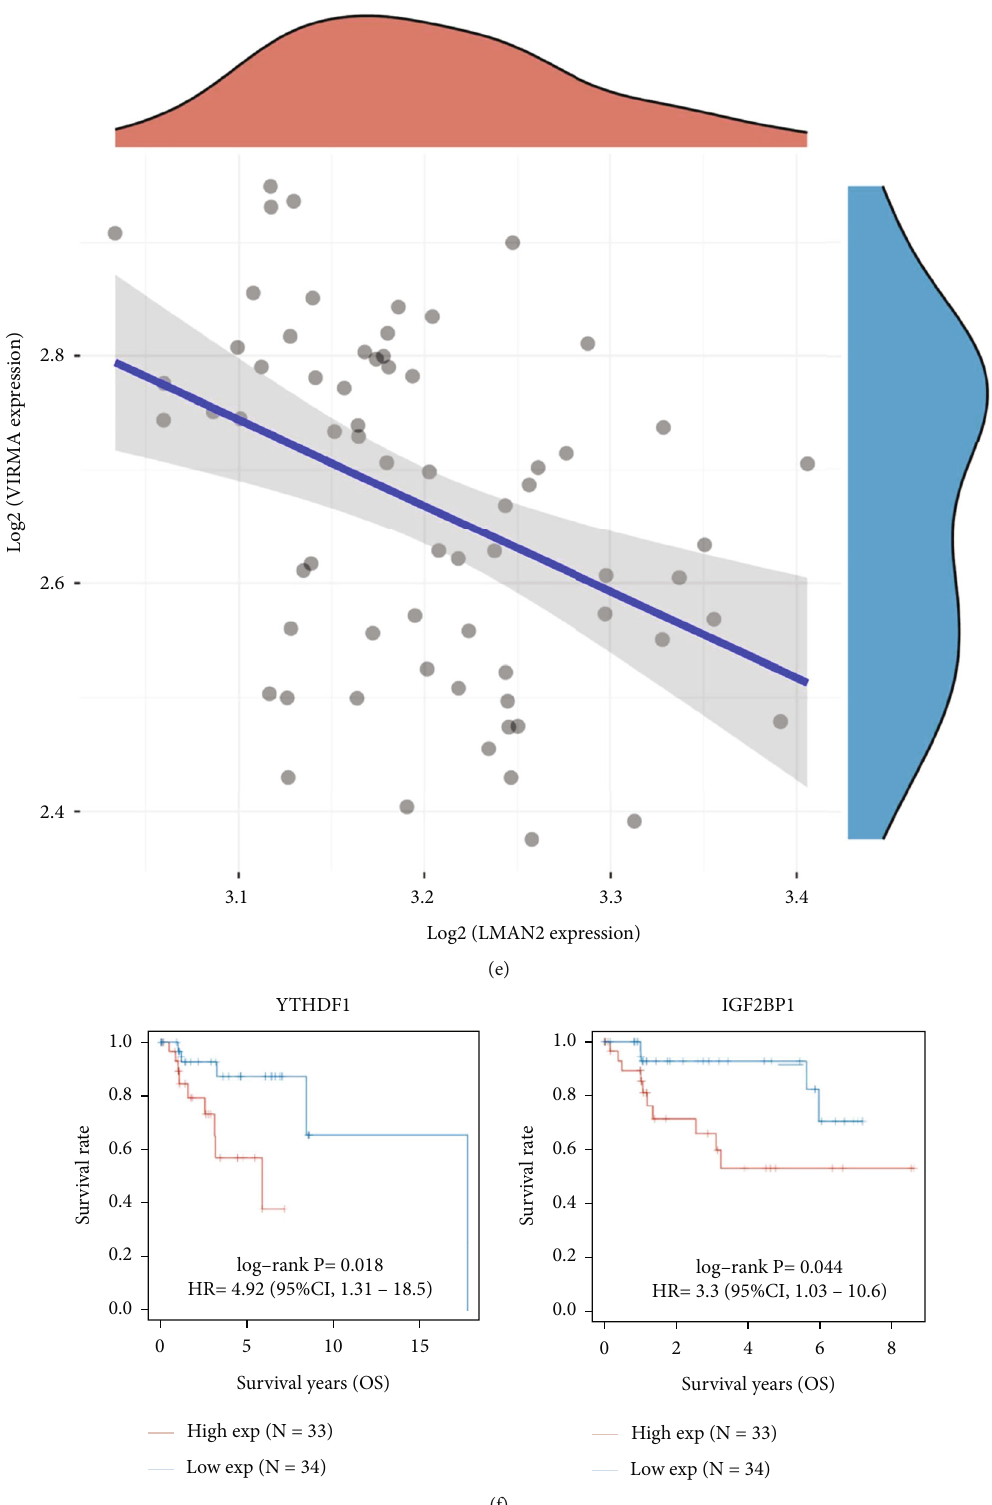
Figure 6: m6A modi fi cations in the LMAN2 gene. (a) Di ff erences in m6A expression in HER2 subtypes. G means tumor group. (b) Correlation analysis of m6A in HER2 subtypes. (c) Prediction of results based on the LMAN2 sequence. (d) De novo m6A motif result of GSM1135024. (e) VIRMA is inversely linked to LMAN2 expression. (f) Prognostic analysis of the prognosis of VIRMA and YTHDF1 in HER2 subtypes ( ∗∗∗ p ≤ 0 : 001 ; ∗∗ p ≤ 0 : 01 ; ∗ p ≤ 0 : 05